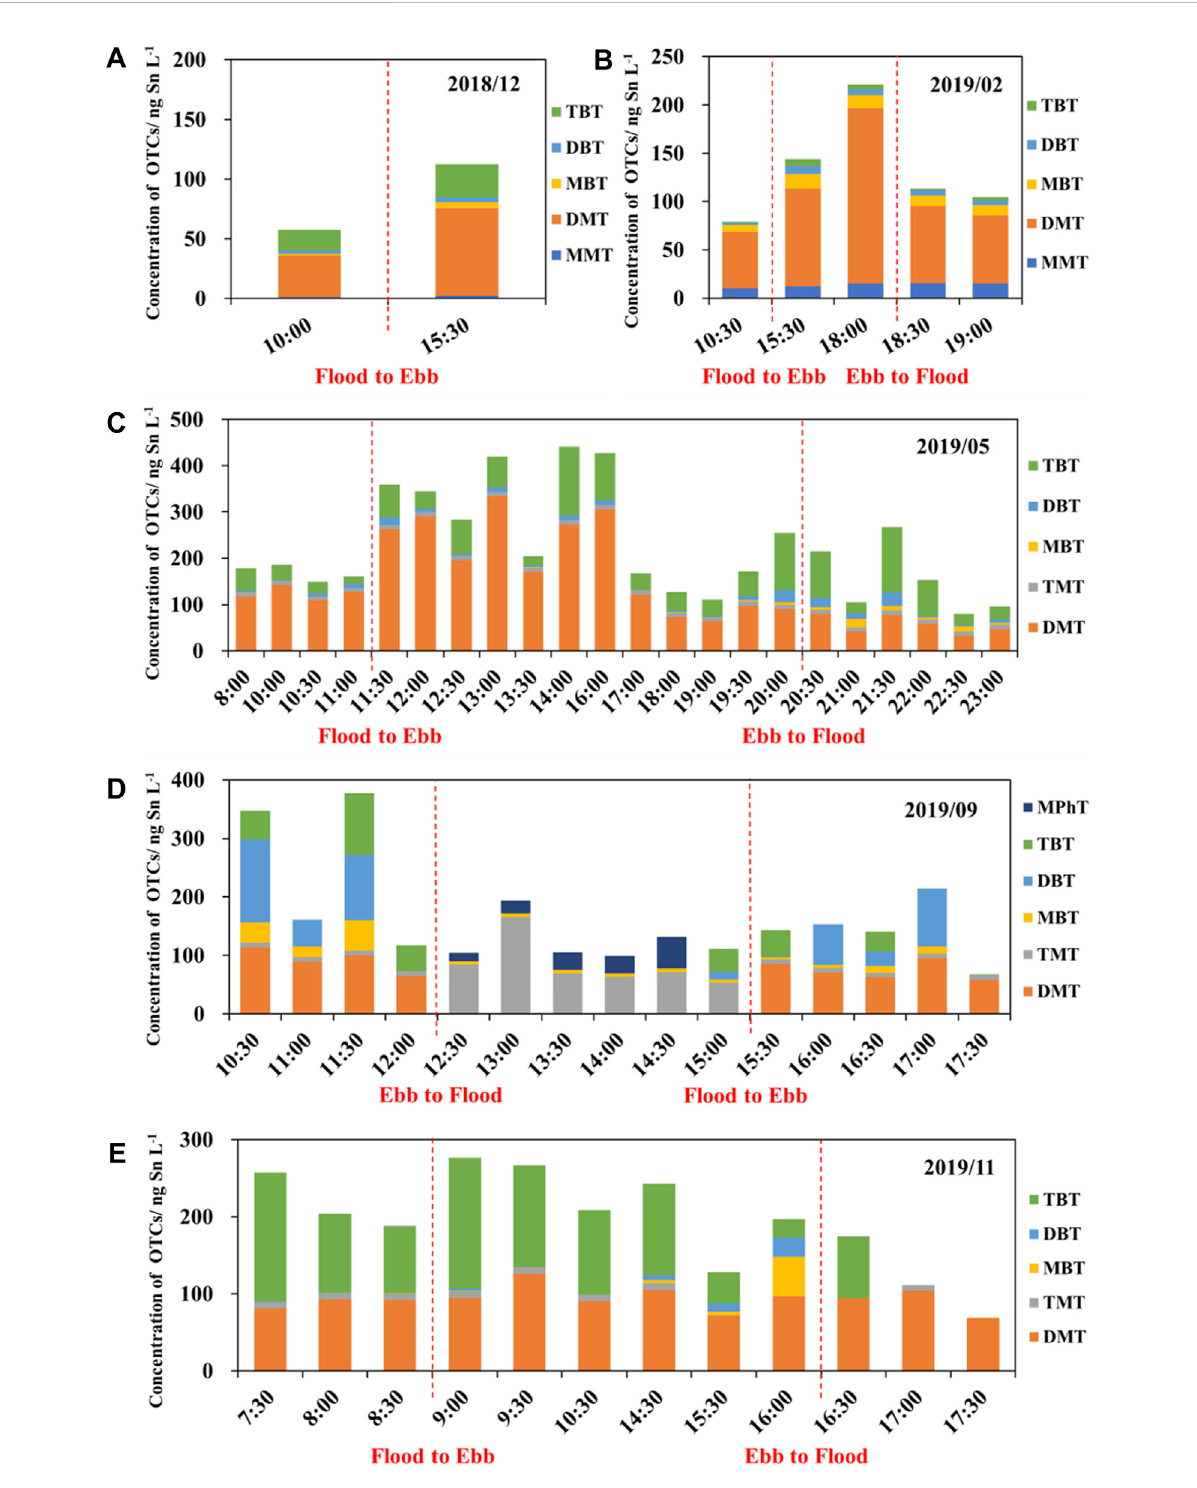
FIGURE 3 Compositions and concentrations of organotin compounds (OTCs) in the drinking water source of the Yangtze River Estuary under semi- diurnal tidal cycle for different months from December 2018 (A) to November 2019 (E)